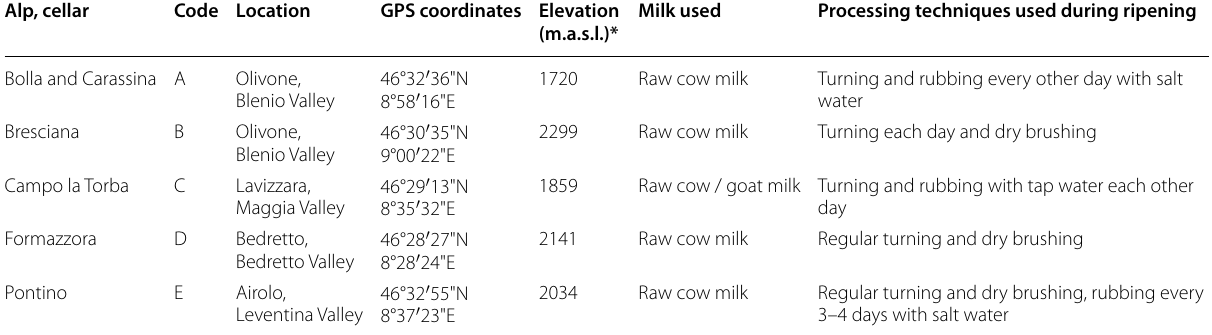
* m.a.s.l. meters above sea